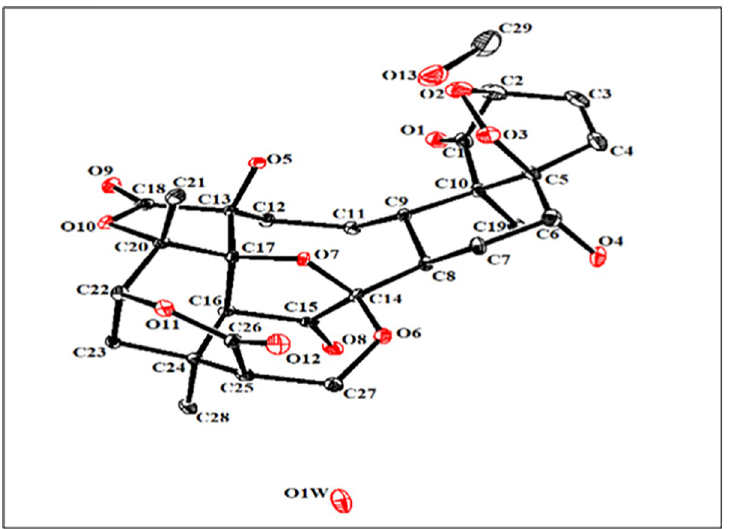
Fig 6. ORTEP view of compound 8 at 50% probability